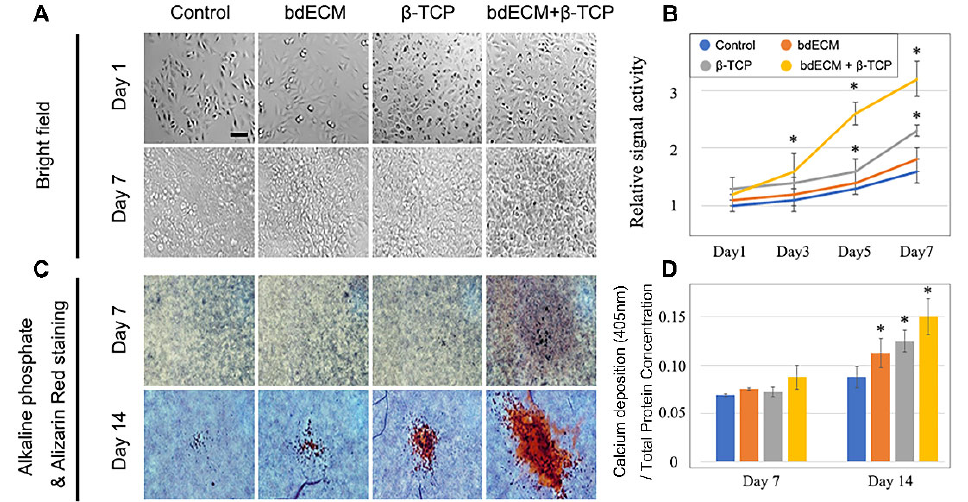
Figure 1. Effects of three different materials on the pre-osteoblast cell line MG63 ( A , B ). Cell number was increased in the group of bdECM + β -TCP compared to control in Days 3, 5, and 7; ( C ). Bone formation was also increased in the group of bdECM + β -TCP compared to control in Day 14; ( D ). Calcium deposition was measured and normalized by cellular protein content. Similar to the bone formation, calcium deposition was also increased in the group of bdECM + β -TCP compared to control in Day14. Asterisk indicates significant difference ( p < 0.05) compared to control. Scale bar indicated 20 μ m.